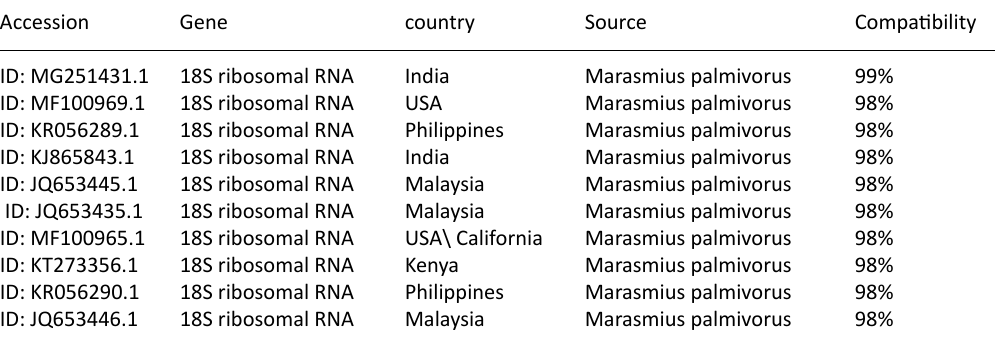
ph As a constant, pH (4.5, 5.5, 6.5, 7.5, and 8.5) has a significant effect on the growth of M.